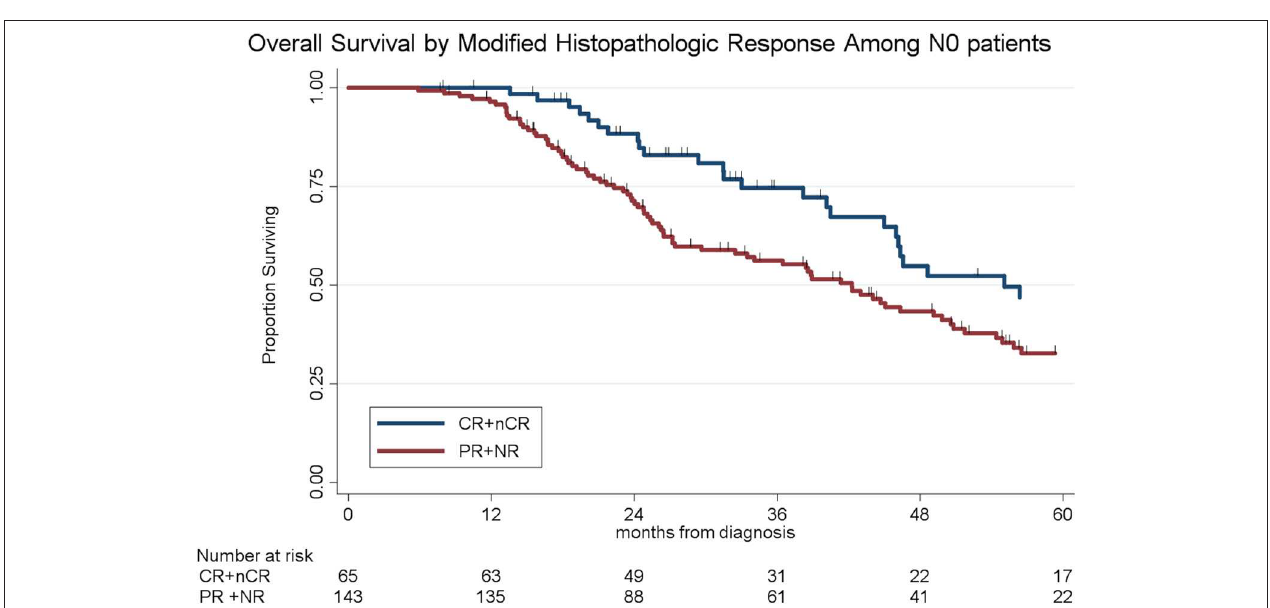
FIGURE 4 | Overall survival by modified histopathologic response among N0